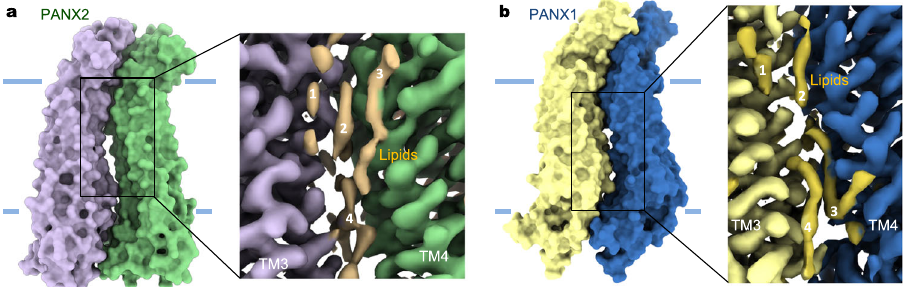
Fig.2|FenestrationinPANX2andPANX1.a LateralopeningbetweentwoadjacentPANX2subunits.Lipid-likedensities(inorange)arenumberedaslipid1to4. b Lateral opening between two neighboring PANX1 subunits (PDB: 6UZY). Interfacial lipid densities (in orange) are similarly